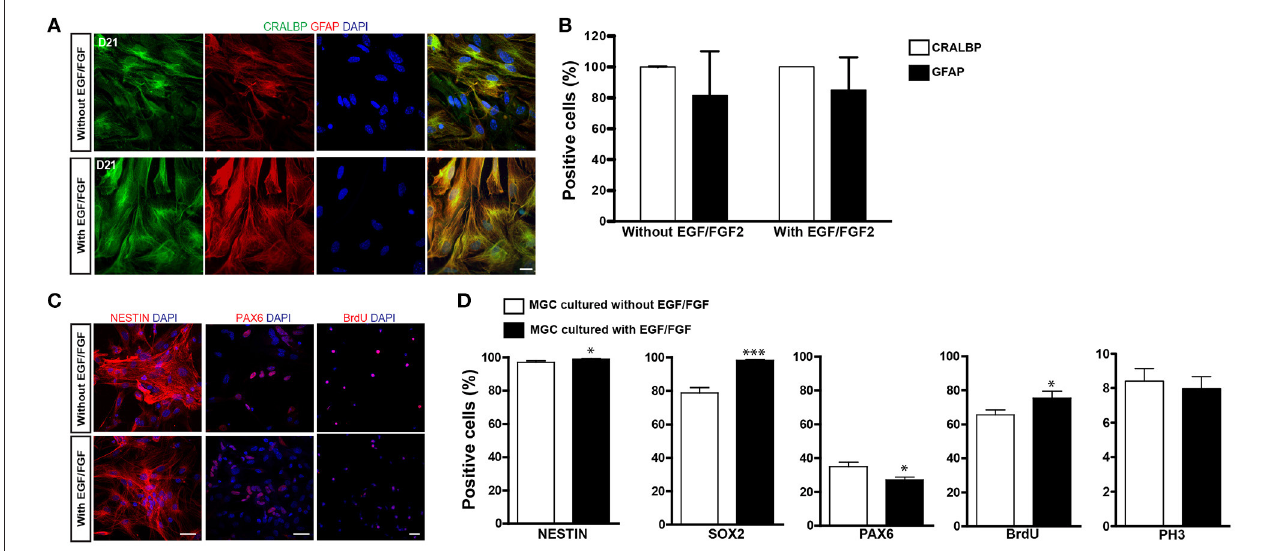
FIGURE 1 | Characterization of MGC cultures expanded with or without EGF/FGF2. (A) Representative photomicrographs of MGC cultures showing the expression of CRALBP (green) and GFAP (red) 21 days after expansion in the absence (top) or presence (bottom) of EGF/FGF2. (B) Frequencies of CRALBP and GFAP positive cells in enriched MGC cultures. (C) Immunolabeling for NESTIN, PAX6, and BRDU (red) in MGCs expanded in the absence (top) or presence (bottom) of EGF/FGF2. (D) Frequencies of MGCs immunolabeled for NESTIN, SOX2, PAX6, BrdU, and PH3 prior to lineage reprogramming (* p < 0.05; *** p < 0.001; Unpaired t -test). Scale bars: 20 µ